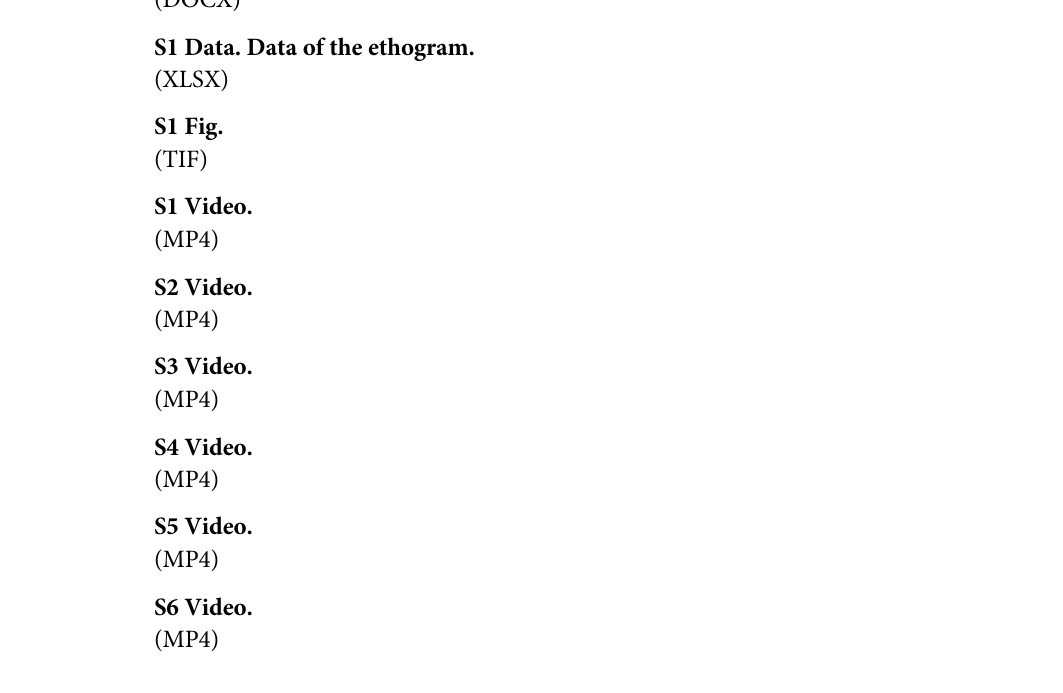
S1 Table. Video examples of each perioperative behaviour in rabbits submitted to ortho- paedic surgery. S2 Table. Median and interquartile range (Q1 –Q3) of behaviours of the 28 rabbits under- going orthopaedic surgery that did not alter over time or between the presence and absence of observer. Frequency (F) in number of occurrences and duration (D) in seconds in each of the 300 second (five minute) observations of behaviours that were not different over time or between the absence and presence of the observer, observed in the 28 rabbits undergo- ing orthopaedic surgery in the moments before surgery (Baseline); 1 hour after recovery from anaesthesia (Pain); 4 hours after recovery and 3 hours after rescue analgesia (Analgesia); and 24 hours after recovery from anaesthesia (24h